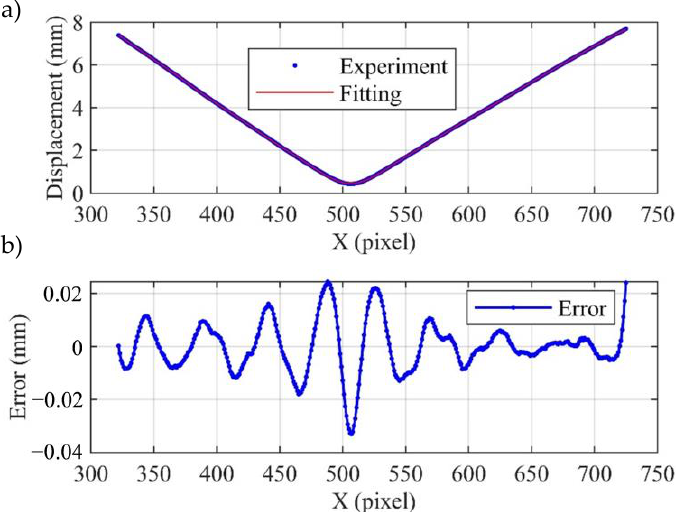
Figure 9. The displacement at the dashed line. ( a ) Comparison of experimental results and fitting results; ( b ) error.